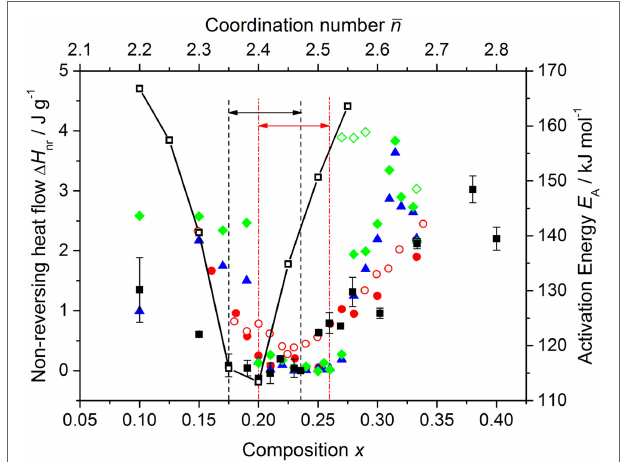
FIGURE 5 | The dependence of the measured non-reversing enthalpy ∆ H nr for the Ge x Se 1 (cid:0) x system on the composition x and mean coordination number ¯ n = 2 ( 1 + x ) . The results from the present work [solid (black) squares (cid:4) with vertical error bars] are compared to those of Feng et al. (1997) ◦ • [open (red) circles ]; Boolchand et al. (2007) [solid (red) circles ]; and Bhosle et al. (2012b) where the samples were investigated as prepared [solid (blue) triangle N ], after aging for two weeks at room temperature [solid (green) diamonds (cid:7) ], or after aging for two weeks at 240°C [open (green) diamonds ⋄ ]. The pairs of vertical dashed (black) or chained (red) lines, and associated horizonal arrows, mark compositions for which ∆ H nr ≃ 0 as found in the present work (0.175 ≤ x ≤ 0.235) or in the work of Boolchand et al. (2001a) (0.20 ≤ x ≤ 0.26), respectively. Also shown is the composition dependence of the activation energy for enthalpy relaxation E A as measured in the DSC experiments of Lucas et al. (2009) [open (black) squares (cid:3) ].